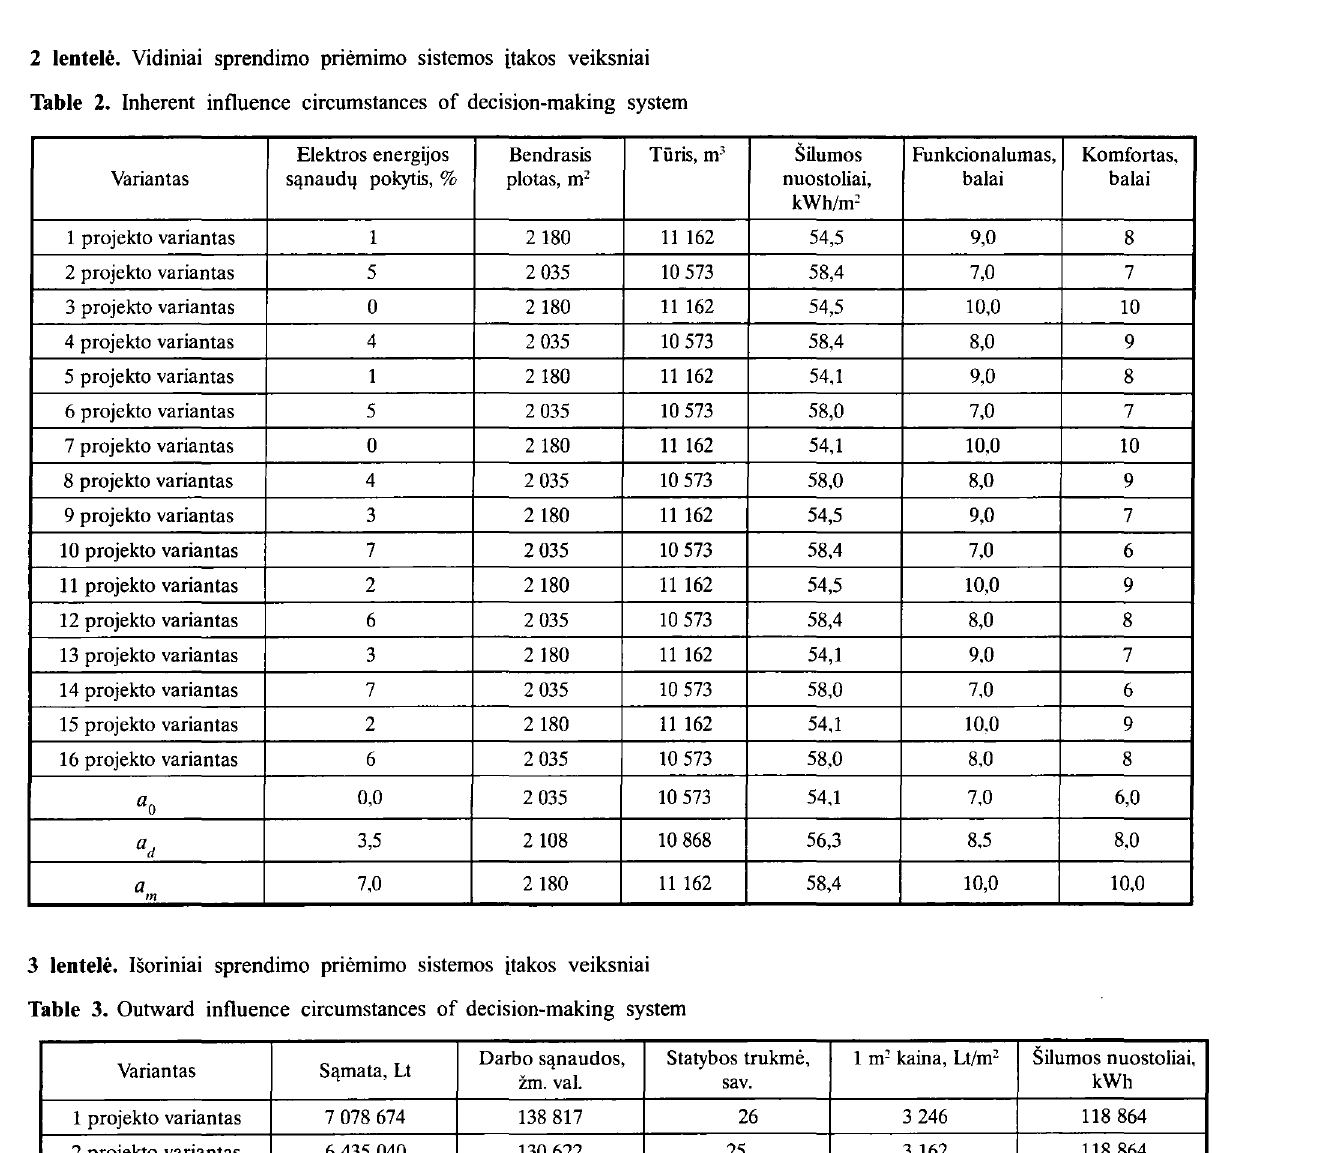
Table 3. Outward influence circumstances of decision-making system Darbo S<jnaudos, Statybos Variantas S<jmata, Lt